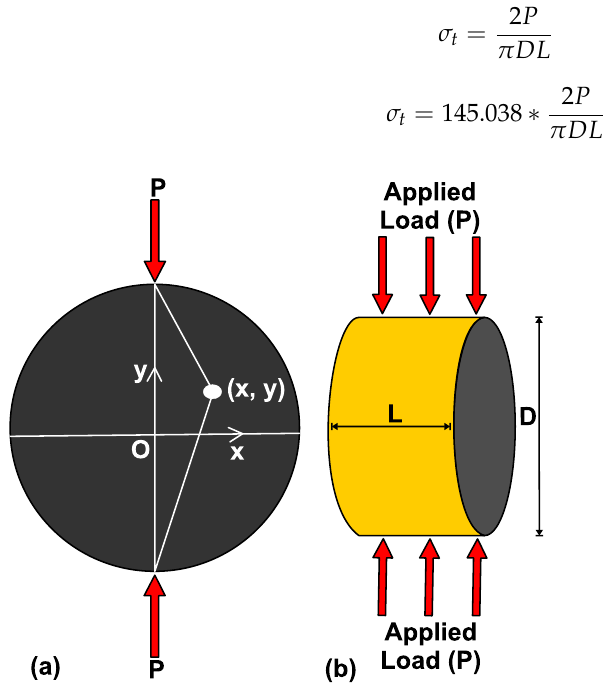
Figure 1. BITS testing’s associated parametric configurations. ( a ) State of stress at point (x, y) on an isotropic Brazilian disc, and ( b ) diametrical compressional loading of the test specimen with diameter (D) and thickness (L) (Modified after: Li et al. [12]).